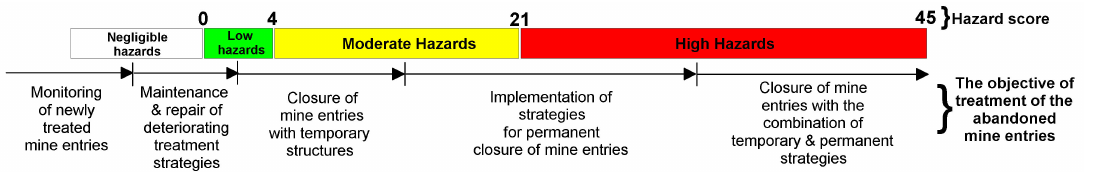
Figure 7. An illustration of the best approach for treatment of abandoned mine